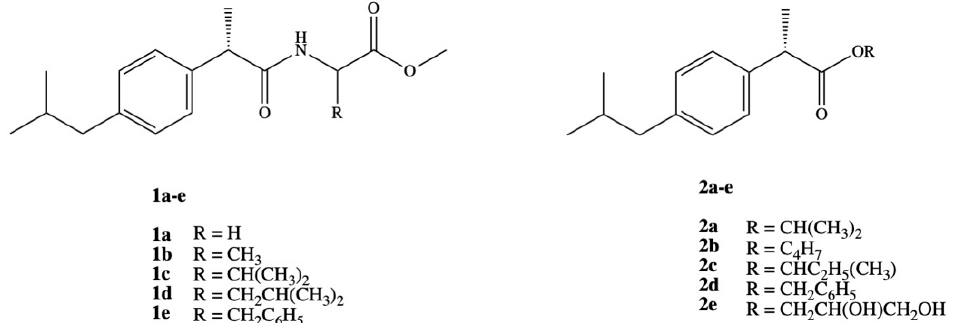
Figure 3. Amide and ester prodrugs of dexibuprofen.